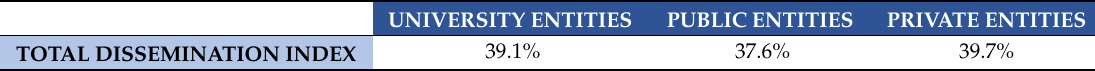
Table 3. Global dissemination index by type of entities (own